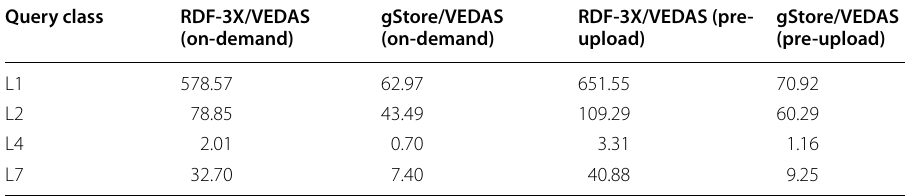
Table 10 LUBM benchmark’s speedup compared against RDF-3X and gStore Query class